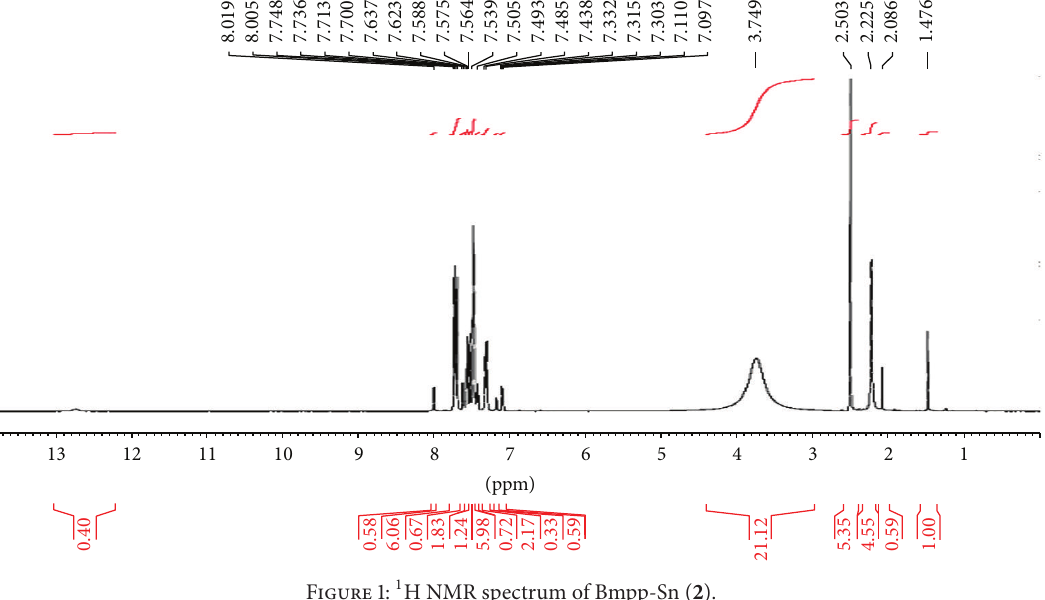
Figure 1: 1 H NMR spectrum of Bmpp-Sn ( 2 ).